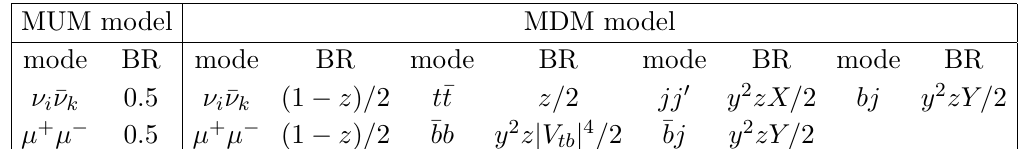
Table 1 . Summary of BRs (BRs) of Z 0 for the MUM and MDM models. We have categorised the three lighter quarks and anti-quarks into a generic ‘light’ jet j; j 0 2 f u; d; s; (cid:22) u; (cid:22) d; (cid:22) s g . i and k 2 f 1 ; 2 ; 3 g are family indices, X (cid:17) is de(cid:12)ned in eq.